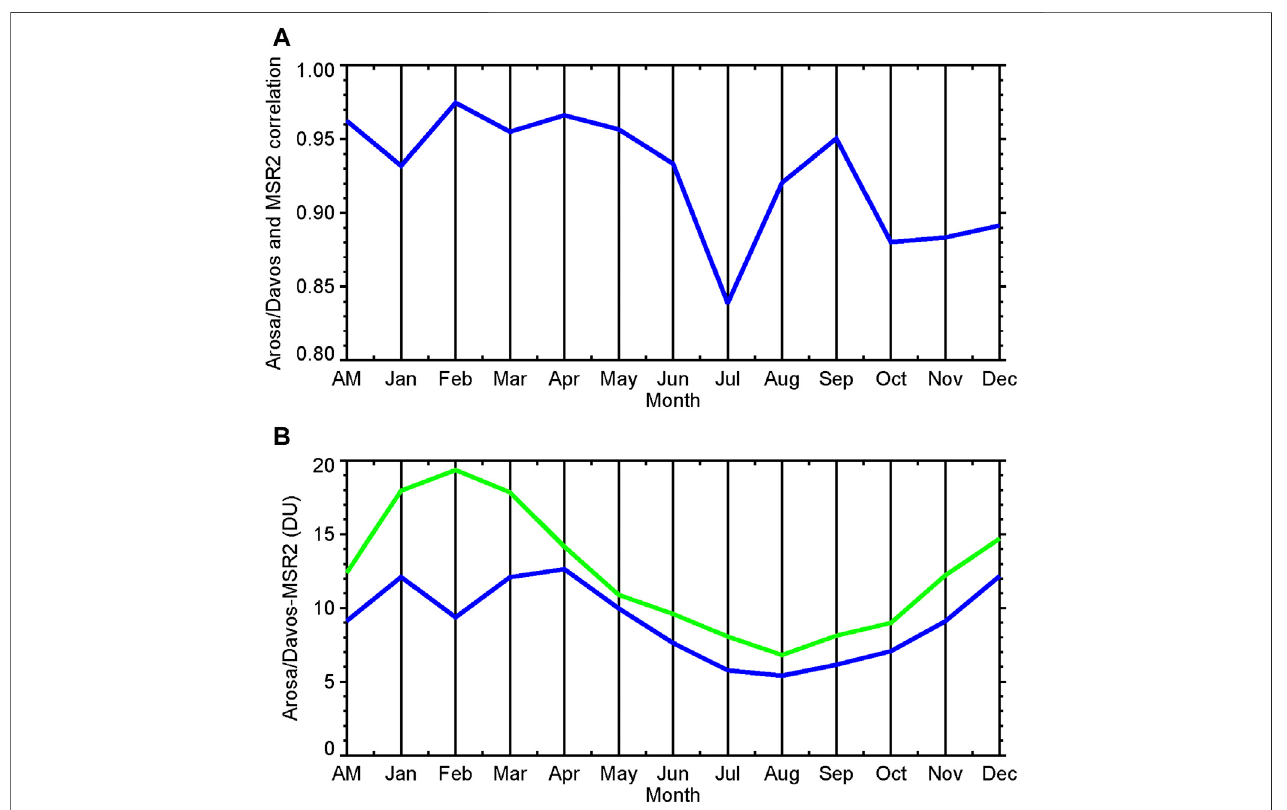
FIGURE2 | The correlation coef fi cient (A) and absolute difference (B) betweenthe monthly mean total column ozone at Arosa and Davos sites and MSR2 data for the closest grid cell. The green line shows MSR2 data uncertainty. AM stands for annual mean.